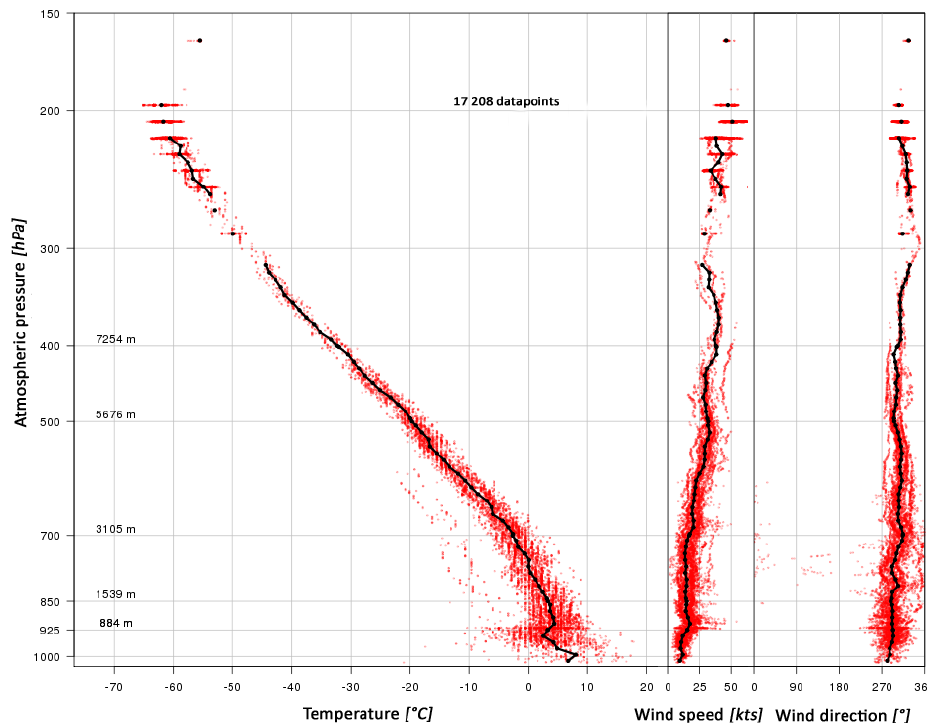
Figure 13. Temperature and wind profile on 21 April 2016 at 09:00UTC, based on Mode S transponder data derived with an ADS–B receiver of ascending and descending aircraft in the vicinity of the two Berlin airports (Bütow, 2016).